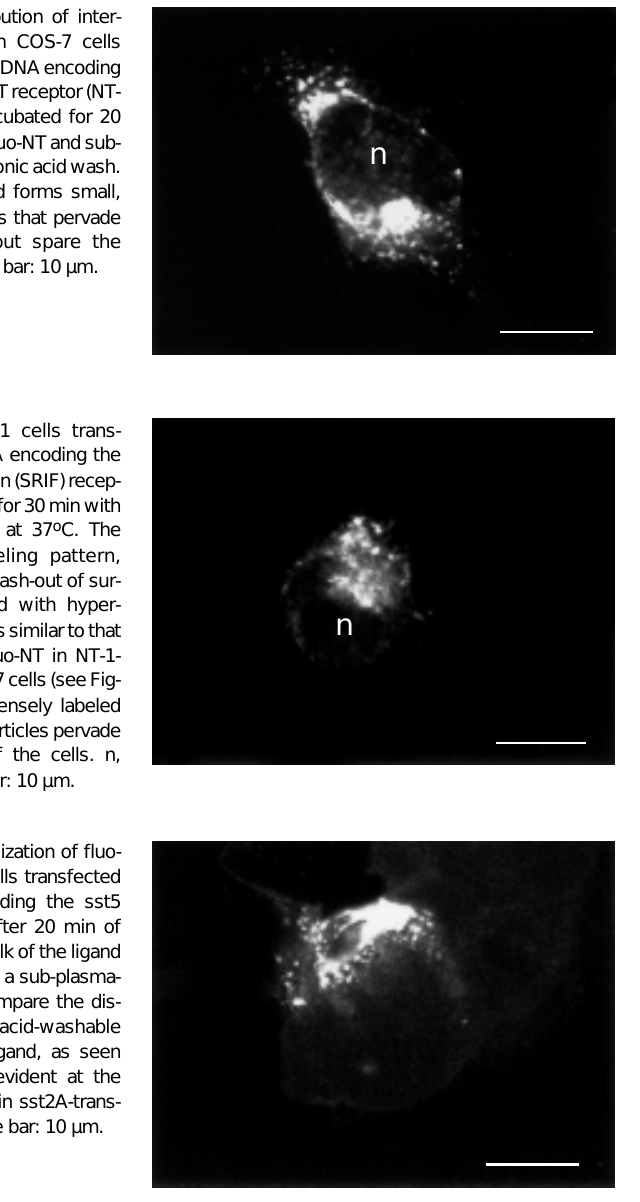
Figure 4 - Distribution of inter- nalized fluo-NT in COS-7 cells transfected with cDNA encoding the high-affinity NT receptor (NT- 1). Cells were incubated for 20 min with 20 nM fluo-NT and sub- jected to a hypertonic acid wash. Internalized ligand forms small, rounded hot spots that pervade the cytoplasm but spare the nucleus (n). Scale bar: 10 µm.